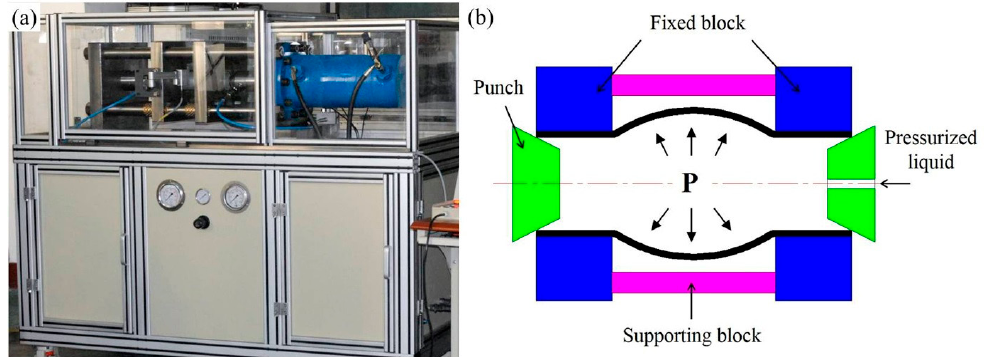
Figure 2. ( a ) Test unit and ( b ) schematic diagram for the hydro-bulging testing of tubes.